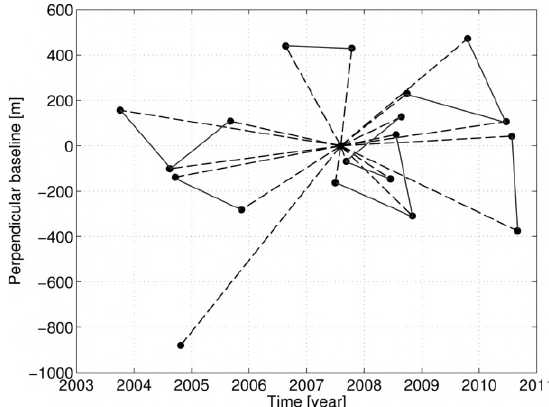
Figure 2. A baseline plot example for the proposed method: dash lines represent SM combinations and solid lines represent the few small-baseline interferograms that are used for obtaining the initial deformation